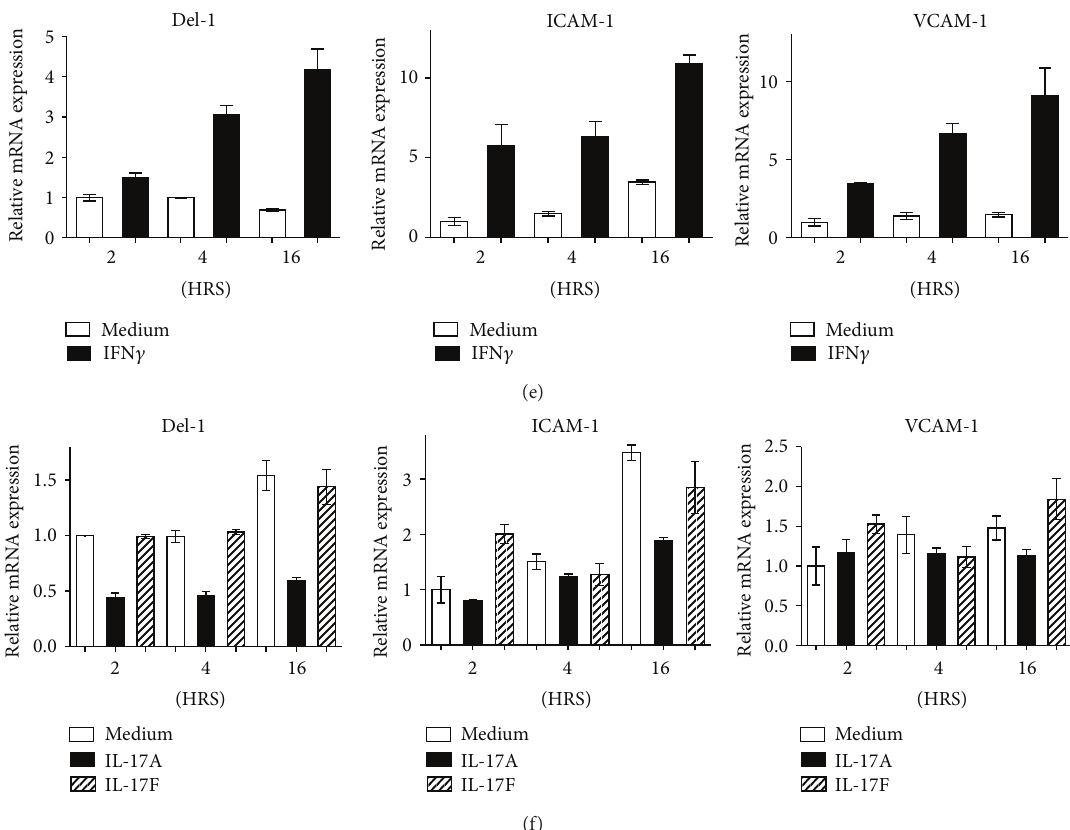
Figure 5: Regulation of Del-1 versus ICAM-1 and VCAM-1 by inflammatory stimuli. HUVEC were cultured for the indicated time intervals with 10ng/mL TNF (a), 5 𝜇 g/mL serum amyloid A (SAA; (b)), P. gingivalis (Pg; MOI = 10: 1) (c), Pam 3 CSK 4 or LPS (both at 0.5 𝜇 g/mL; (d)), 10ng/mL IFN 𝛾 (e), or IL-17A or IL-17F (both at 10ng/mL; (f)) and assayed for Del-1, ICAM-1, and VCAM-1 mRNA expression. Results were normalized to those of GAPDH mRNA and expressed as fold change in transcript levels relative to those of medium-treated cells at 2 hours (HRS), the average value of which was taken as 1. The medium-treated groups in (b) and (c) are the same (SAA and Pg were tested together but were separated in the graphs for enhanced clarity). Data are means ± SD of duplicate determinations from one of three independent sets of experiments that yielded similar